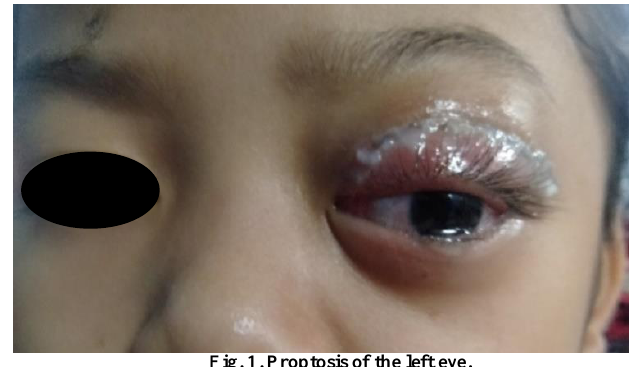
Fig. 1. Proptosis of the left eye. She lost appetite, and there were no petechial patches and no pallor. No symptoms of increased intracranial tension were present. There was no peripheral lymphadenopathy or palpable abdominal organomegaly. A non- reducible axial proptosis of the left eye without subconjunctival hemorrhage was discovered during an ophthalmological examination. She had dystocia and trichiasis and was digitally tense on palpation of the left eyeball. Visual acuity was 6/6 in the right eye and 6/36 in the left eye. Ocular movements were not restricted in all directions, and Pupillary reflexes were positive in both eyes. Both contrast-enhanced CT and MRI of orbits showed left eye proptosis due to the left extraconal lobulated avidly enhancing smoothly marginated lesion in the superolateral aspect measuring (3.6 x 2.3 x 2.8) cm (Figs. 2 and